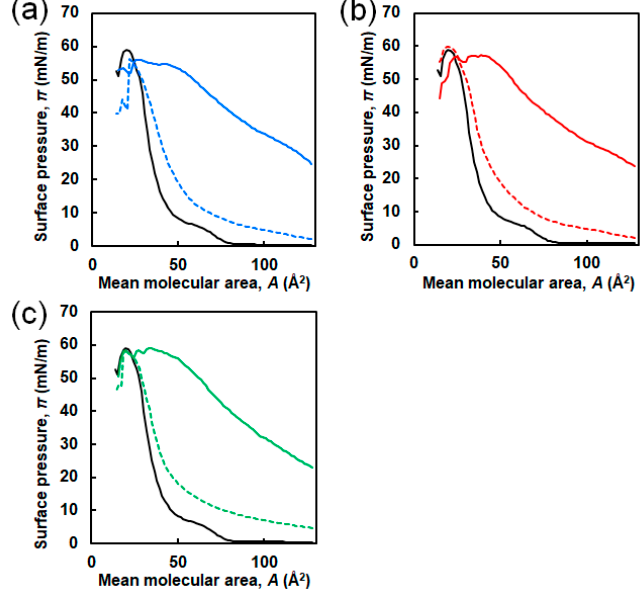
Figure 7. π – A isotherms of DPPC in the presence of ( a ) EG 6 peptides, ( b ) EG 12 peptides, and ( c ) EG 24 peptides. The concentrations of peptides were 0.1 μ M (colored dashed line) and 1.0 μ M (colored solid line). Black lines represent π – A isotherms of sole DPPC.